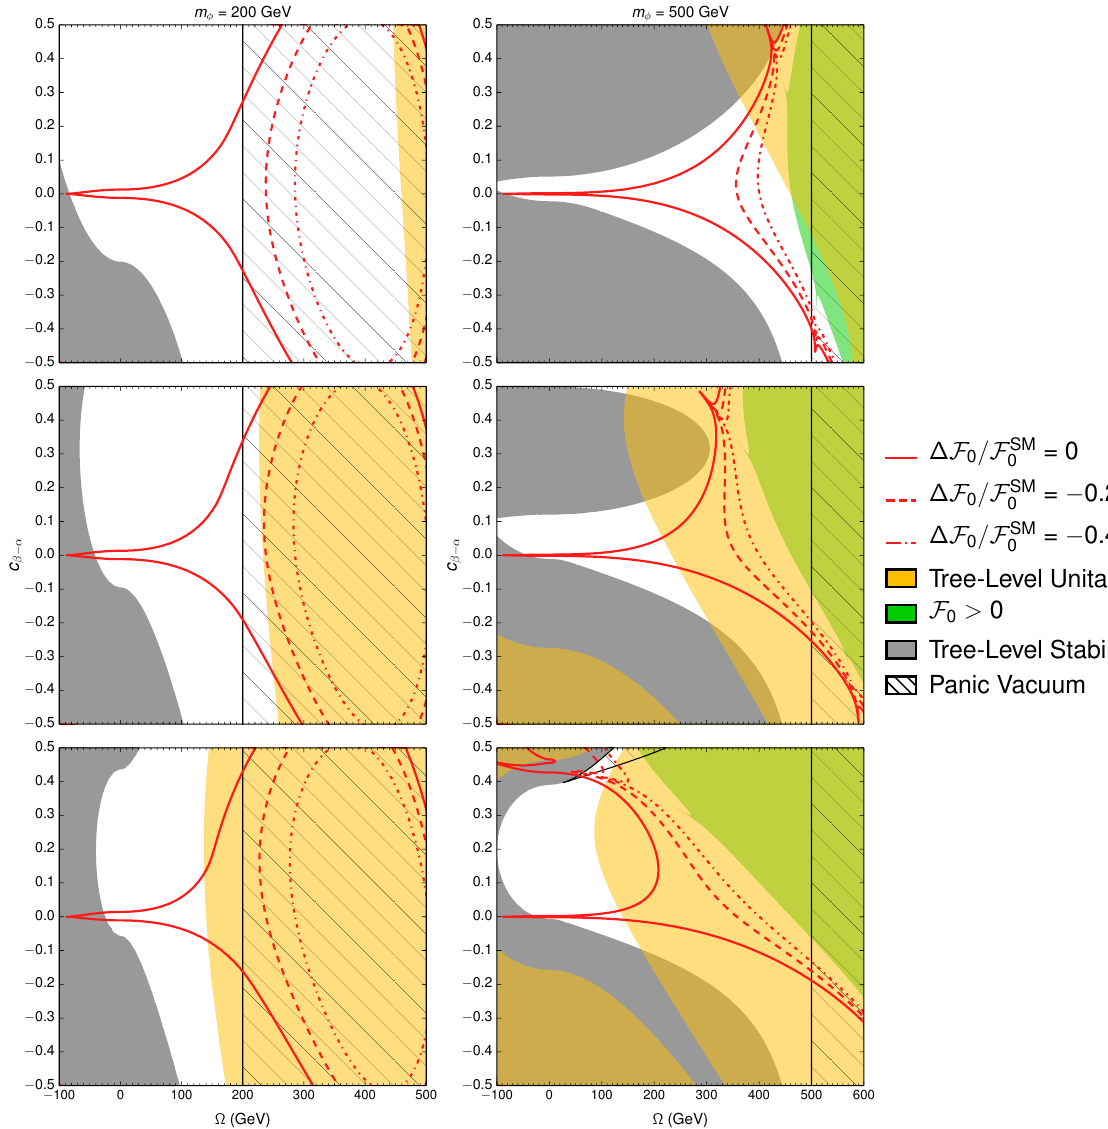
p Figure 9 . (cid:10) (cid:10) 2 sign((cid:10) 2 ) vs c (cid:12) (cid:0) (cid:11) for m (cid:30) = 200 ; 500 GeV (Left to Right) and t (cid:12) = 1 : 5 ; 3 ; 5 (cid:17) j j(cid:2) (Top to Bottom). Red lines show constant values of (cid:1) boundedness from below of the scalar potential, while the orange region is excluded by unitarity. In the hatched region, a panic vacuum